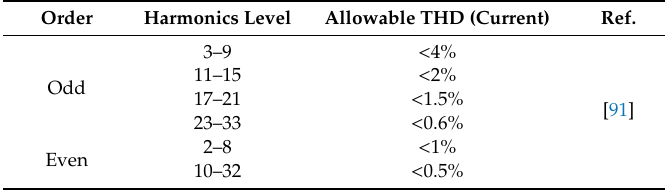
Table 3. Permissible Total Harmonics Distortion for current in the Malaysian distribution network.